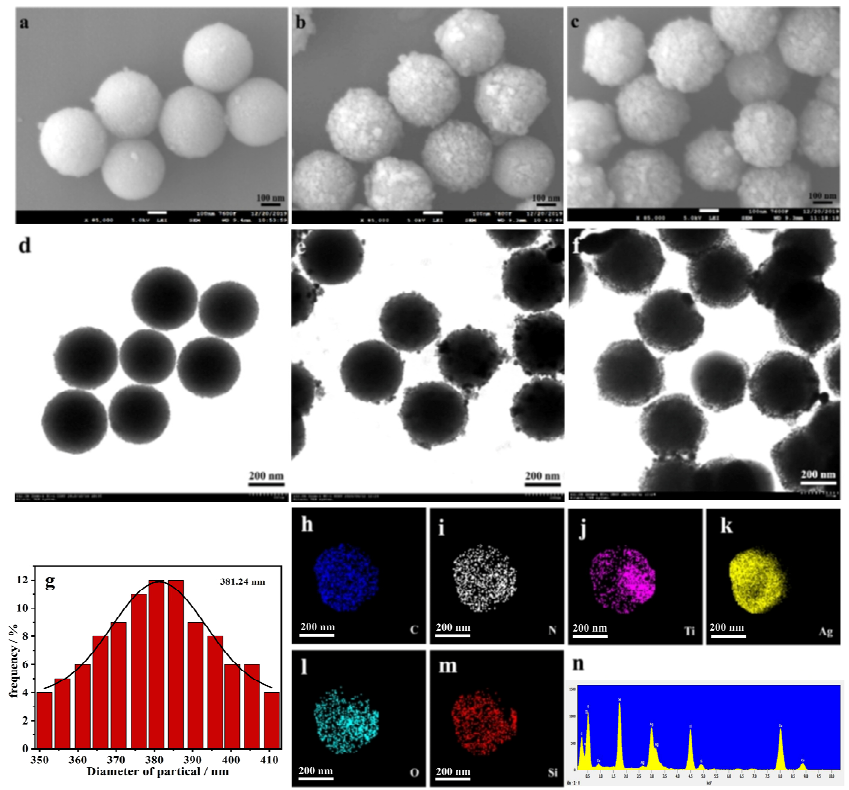
Figure 1. SEM ( a – c ) and TEM images ( d – f ) of SiO 2 /TiO 2 ( a , d ), TiO 2 @Ag ( b , e ), and TM@TiO 2 @Ag ( c , f